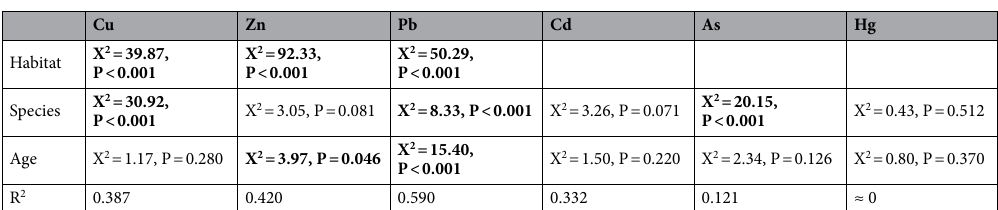
Table 2. Results of the best fitting statistical models testing the link between MTE concentrations (Cu, Zn, Pb, Cd, As and Hg) and the habitat category while taking into account the species, the age and the location. Degrees of freedom were 4, 1 and 1 for habitat, species and age, respectively. Significant effects (P < 0.05) are highlighted in bold.